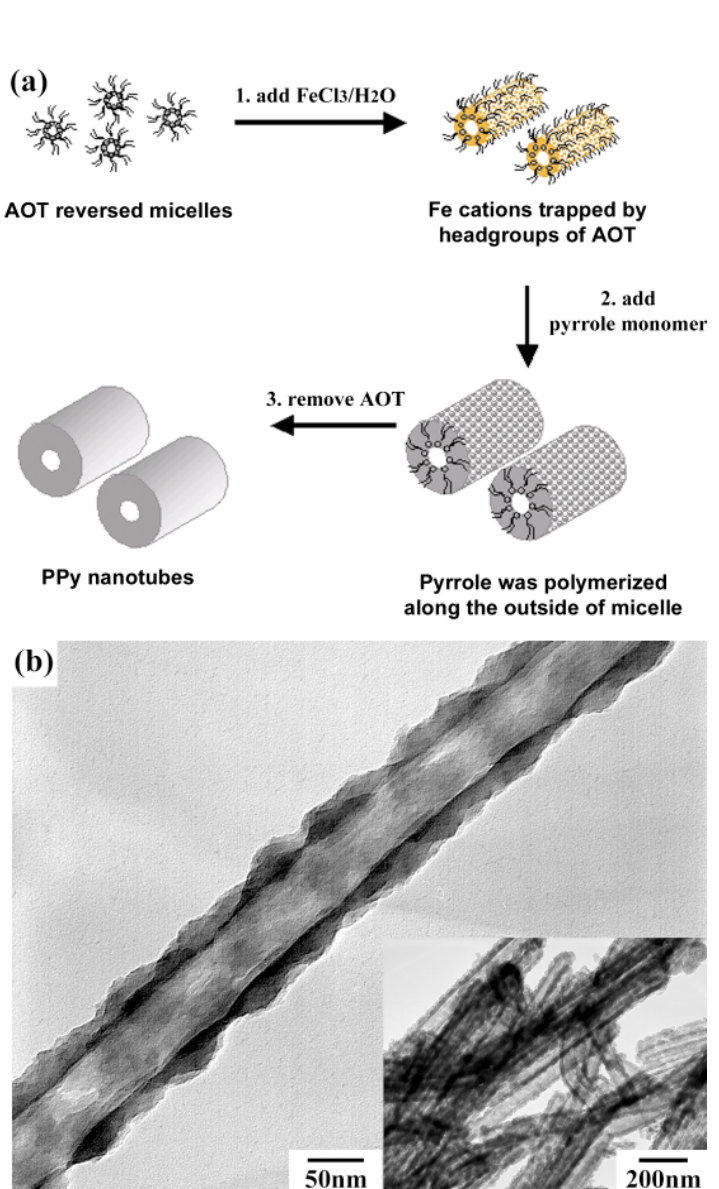
Figure 2. a ) Schematic diagram of Polypyrrole nanotube fabrication using reverse microemulsion polymerization. b ) transmission electron microscopy (TEM) image